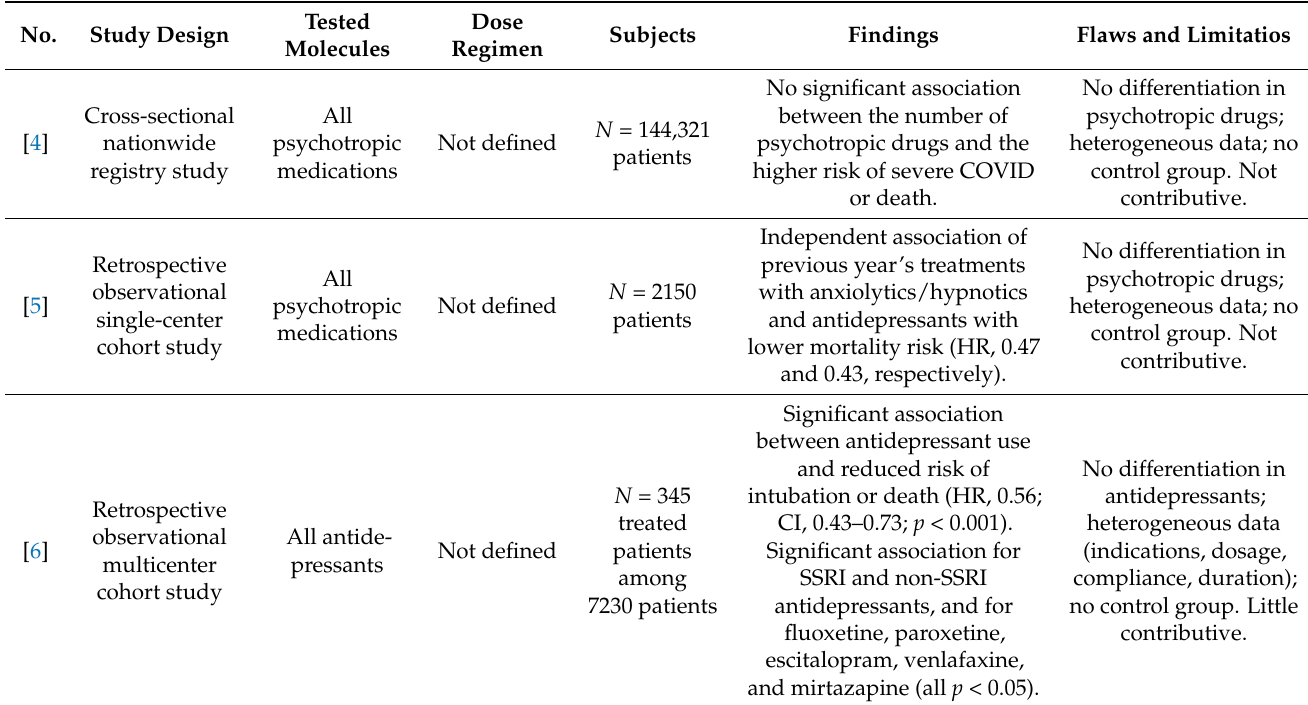
Table 1. Results of the published clinical studies on selective serotonin-reuptake inhibitor antidepres- sant effects in